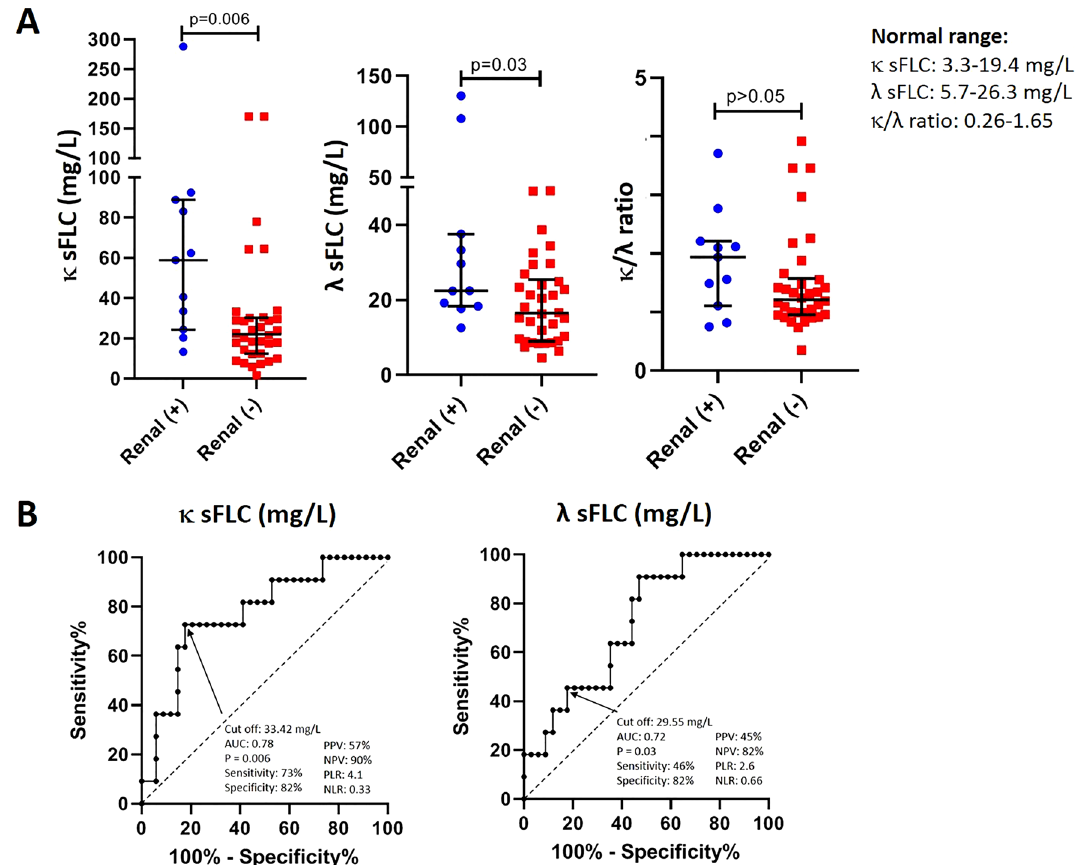
Figure 5. ( A ) Levels of κ and λ serum free light chains were different between IgG4-related disease patients with (n = 11) compare to those without (n = 34) renal involvement (median with interquantile range). Statistics performed by Mann–Whitney U test. ( B ) The receiver operating characteristic curve for κ and λ serum free light chains distinguished patients with renal involvement from patients without. sFLC serum free light chains, PPV positive predictive value, NPV negative predictive value, PLR positive likelihood ratio, NLR negative likelihood